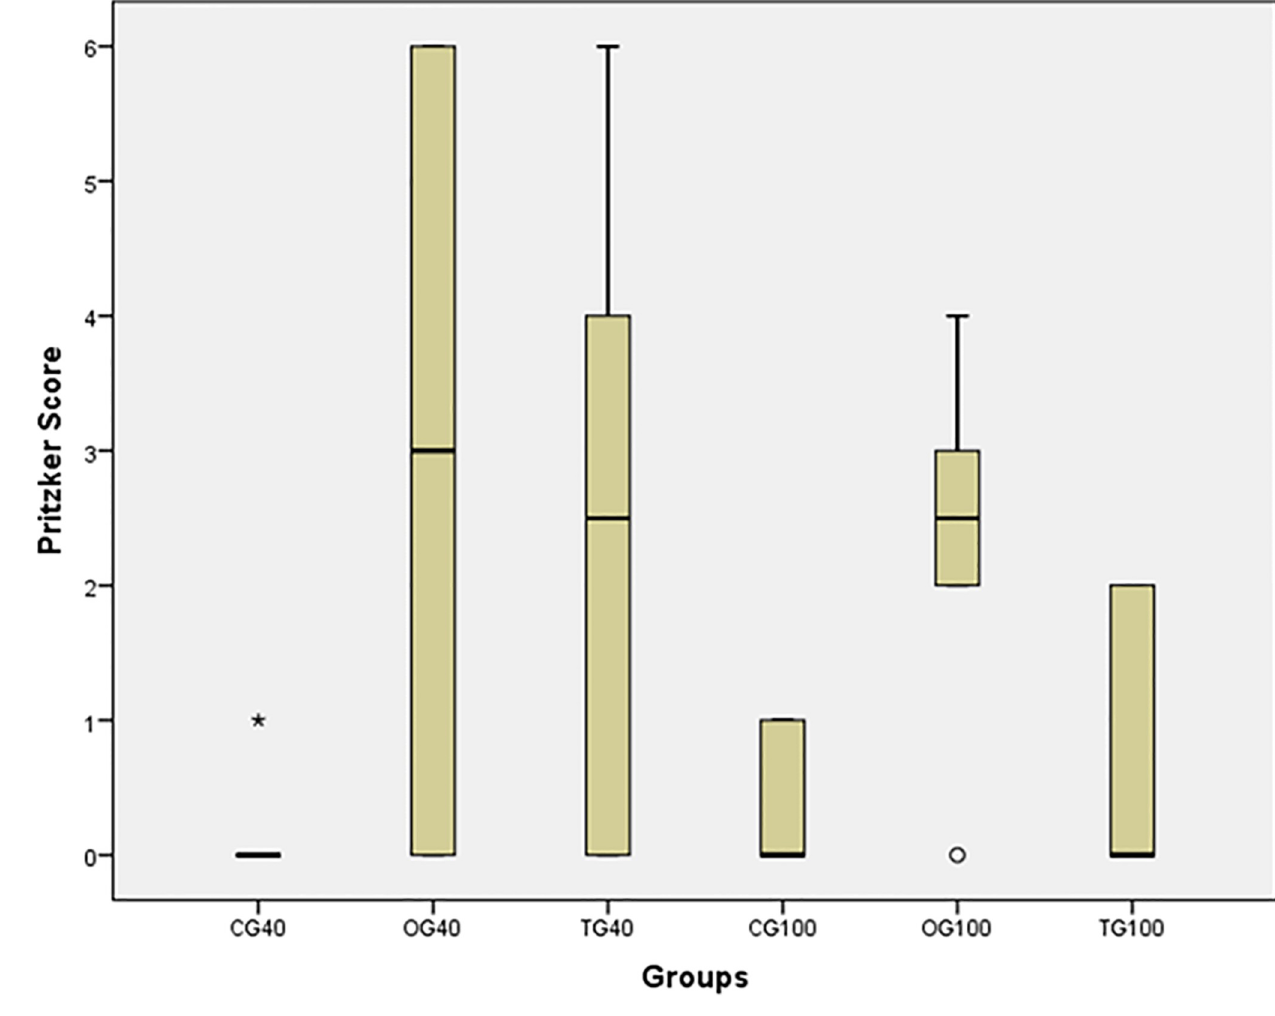
Fig 2. Box plot of median and interquartile range of osteoarthritis severity scores for each group at each assessment time point. Osteoarthritis severity was assessed using the grading system proposed by Pritzker et al. [38], where 0 indicates ‘absence’ and 6 ‘maximum severity’. Control group showed no signs of osteoarthritis at 40 days and insignificant or incipient disease at 100 days. Osteoarthritis group had intermediate median scores at both time points, indicating that disease severity remained stable throughout the study. At 40 days, median scores were similar for the treatment and osteoarthritis groups, but at 100 days the treatment group had lower scores, indicating that treatment with chondroitin sulfate and glucosamine was effective (CG 40 : control group at 40 days, OG 40 : osteoarthritis group at 40 days, TG 40 : treatment group at 40 days, CG 100 : control group at 100 days, OG 100 : osteoarthritis group at 100 days, TG 100 : treatment group at 100